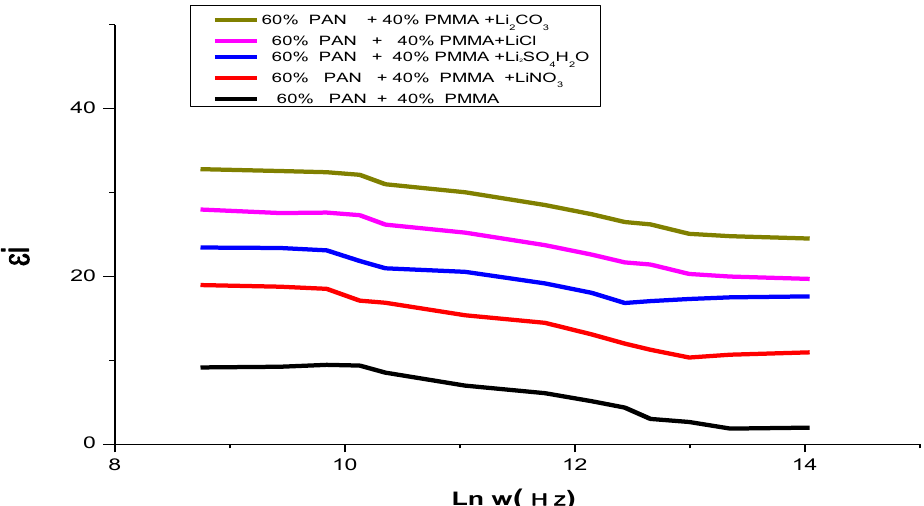
Figure 3e: The imaginary dielectric constant as function of ln (ω) of undoped (60%PAN+40%PMMA) and doped with 20% (LiNO